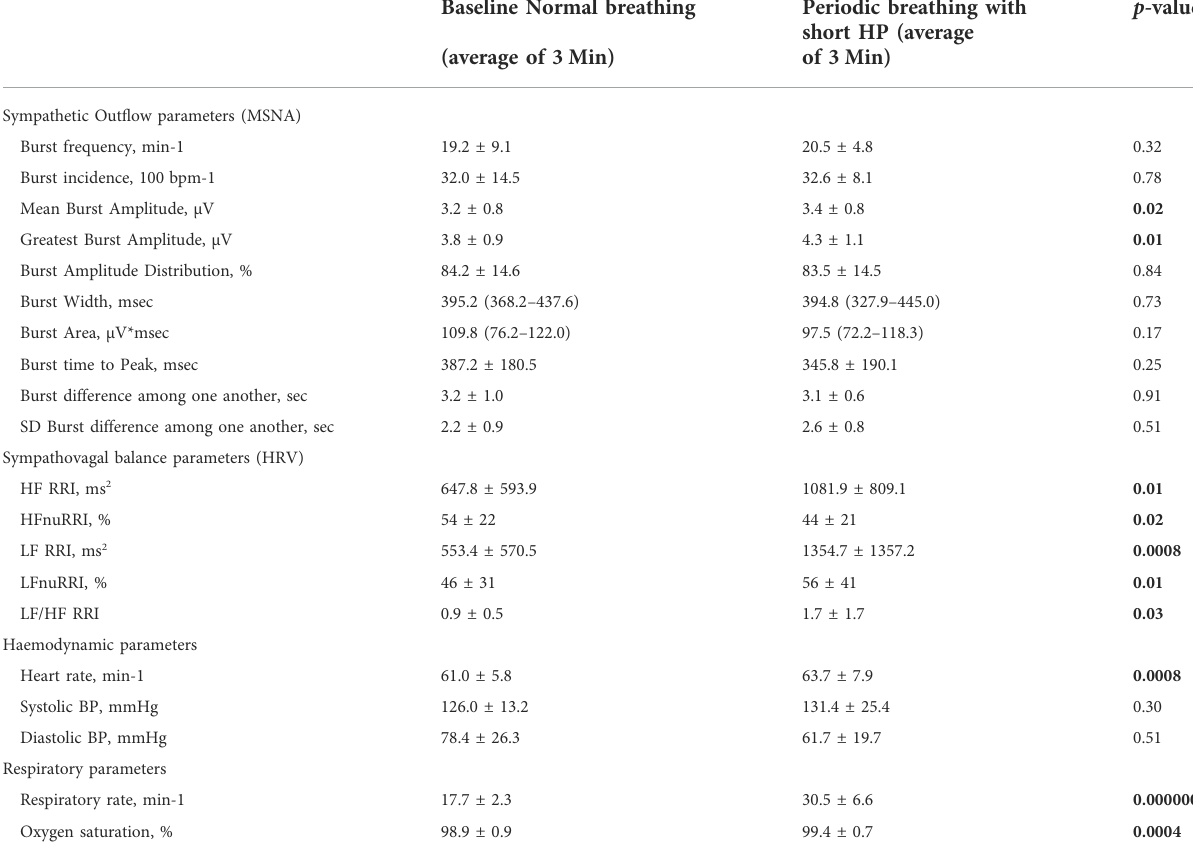
TABLE 1 Comparison of sympathetic out fl ow, hemodynamic and respiratory data between normal breathing and periodic breathing with a short hyperpnea